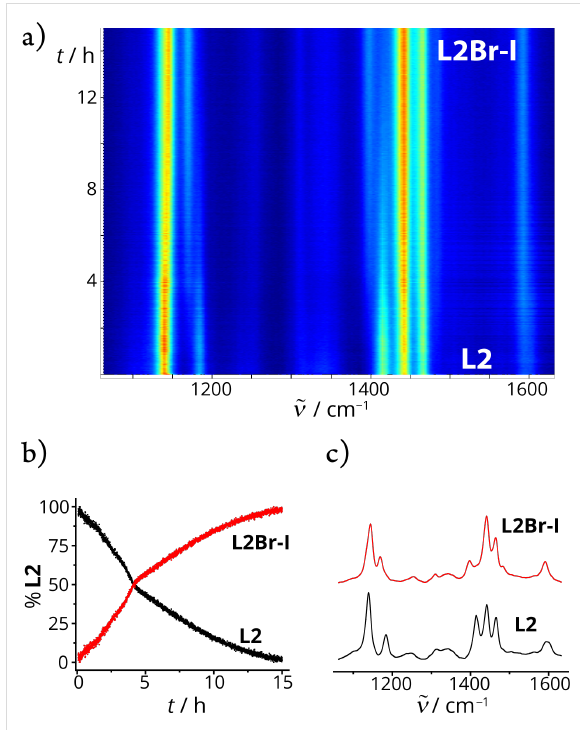
Figure 2: a) Two-dimensional (2D) plot of the time-resolved Raman monitoring of NG of L2 (0.50 mmol) with NBS (0.60 mmol) and SiO 2 (250 mg). b) Reaction profile derived from multivariate curve analysis - alternating least squares fitting (MCR-ALS analysis). c) Extracted Raman spectra of species observed during Raman monitoring.